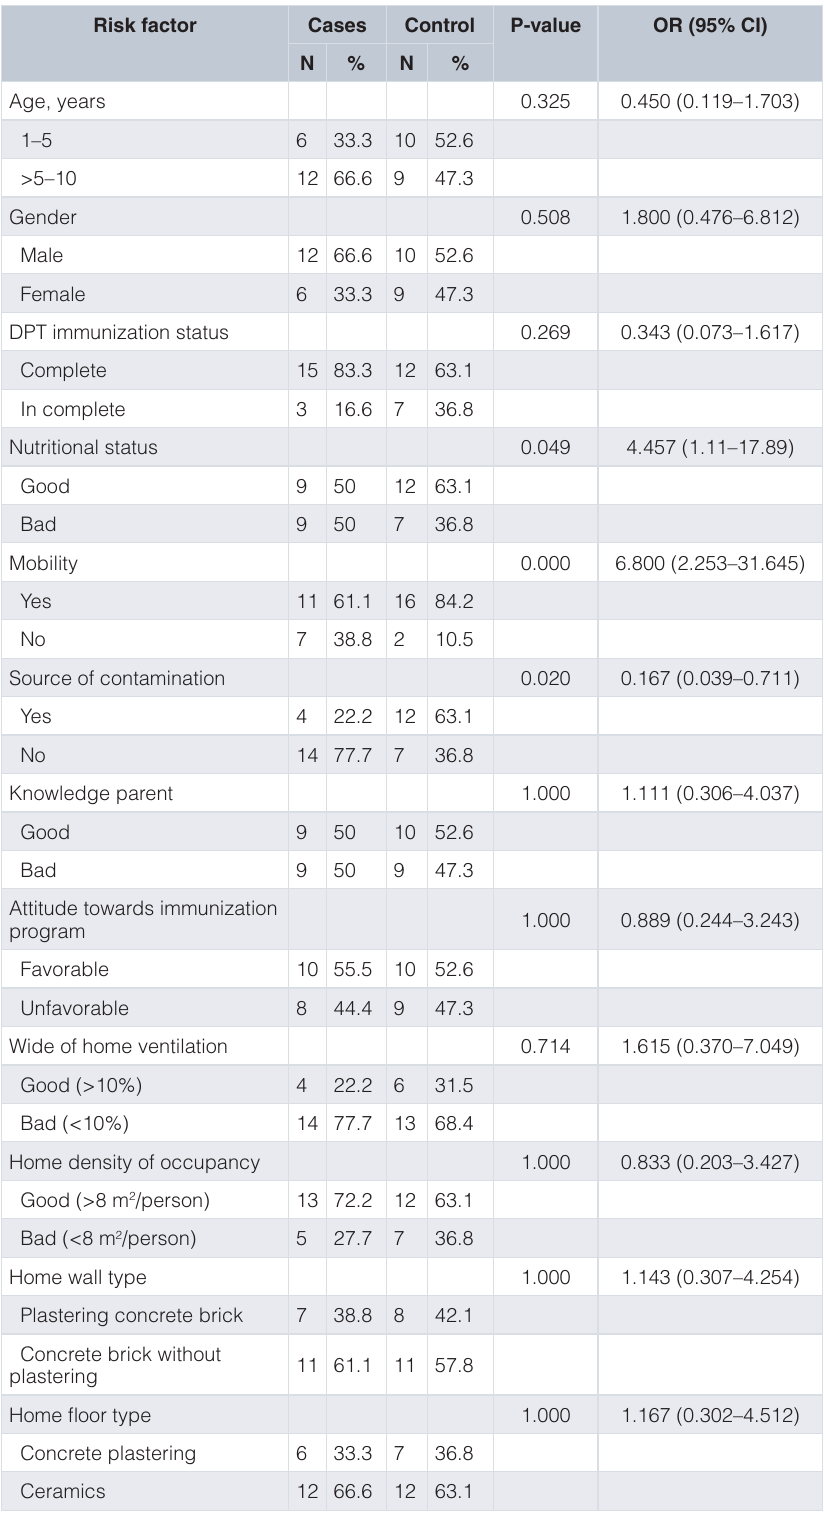
Table 2. Results of bivariate